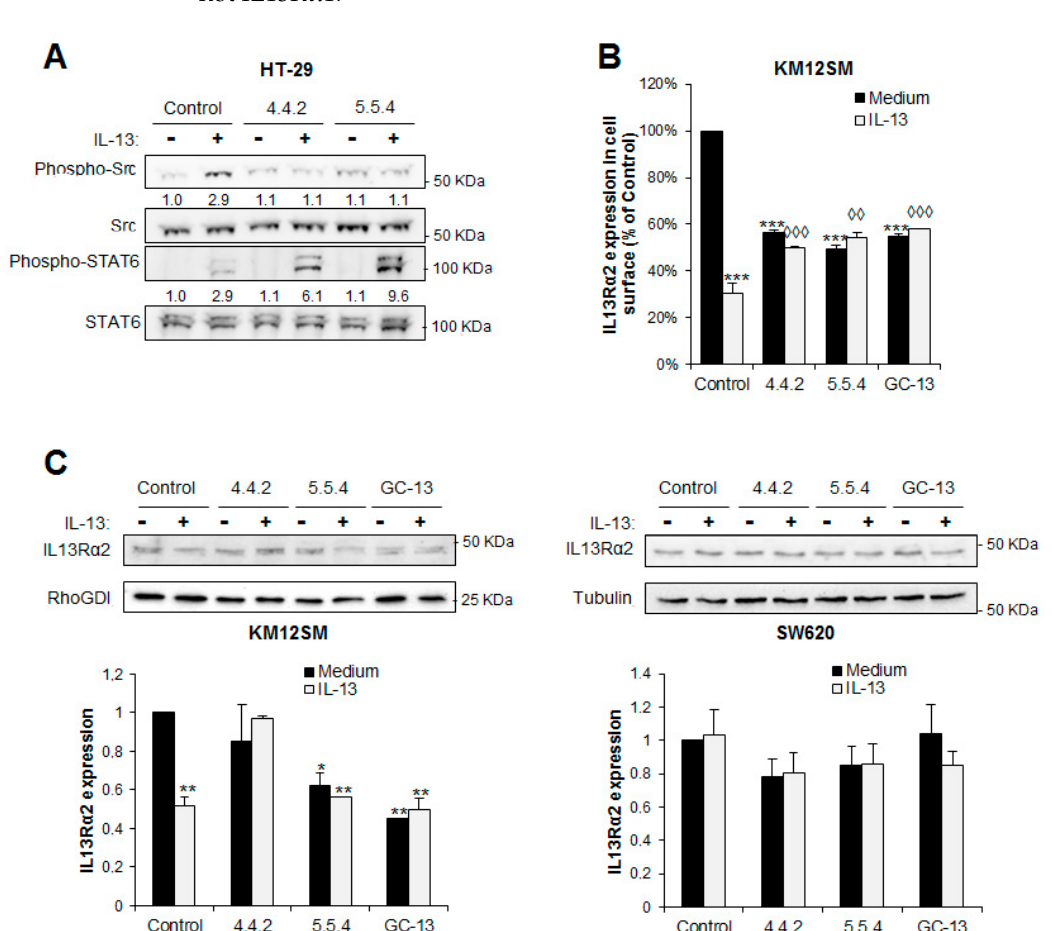
Figure 5. Effect of IL13R α 2 D1 mAbs on IL-13 signaling pathways, receptor internalization and degradation. ( A ) HT29 cells expressing IL13R α 1 and IL13R α 2 receptors were treated or not with IL-13 in presence of the IL13R α 2 D1-specific mAbs and then analyzed by western blot to detect phospho-SRC and phospho-STAT6. Total SRC and STAT6 were used as loading controls. Bands were quantified and normalized with respect to untreated control condition. Both mAbs caused a clear inhibition of SRC activation but not IL13R α 1-mediated STAT6. ( B ) Inhibition of IL-13-promoted receptor internalization by D1-specific mAbs. All D1-specific antibodies inhibited IL-13-induced receptor internalization at a ♦♦ p ♦♦♦ p significant extent ( < 0.01; < 0.001) and the internalization of the receptor by the mAbs compared with a control antibody ( *** p < 0.001). ( C ) Inhibition of receptor degradation after IL13-promoted internalization by D1-specific mAbs in KM12SM and SW620 cells. IL13R α 2 degradation was detected by western blot and quantified by densitometric analysis (* p < 0.05; ** p < 0.01; *** p <